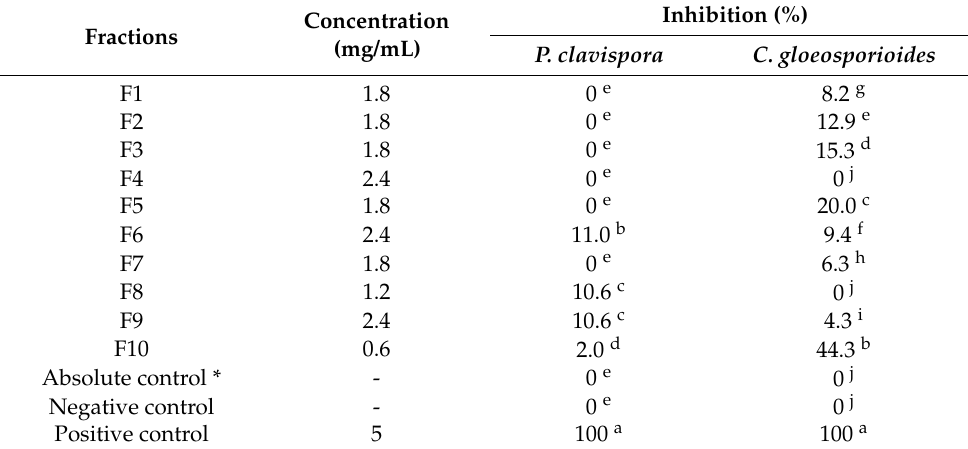
Table 2. Percentage of mycelial growth inhibition of P. clavispora and C. gloeosporioides by fractions from the M5L extract of L. hirta .